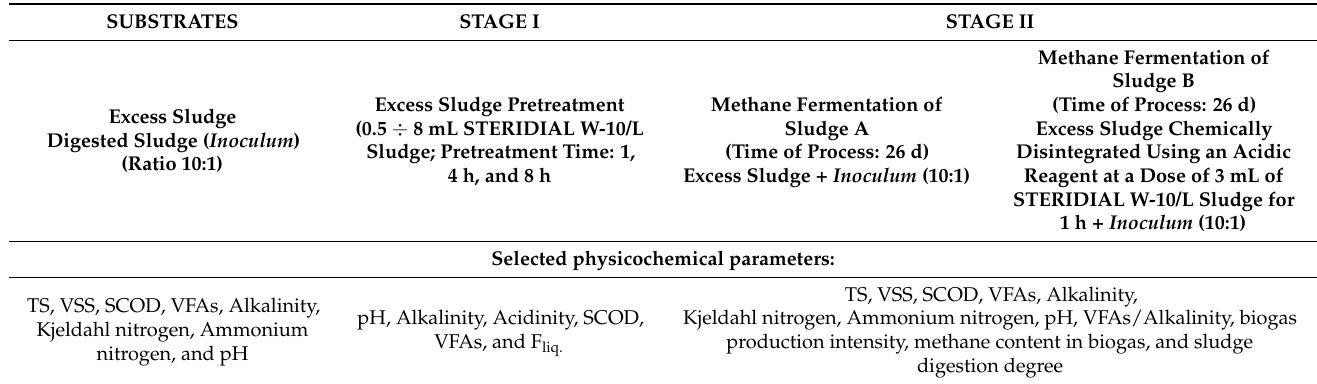
Table 2. Characteristics of research